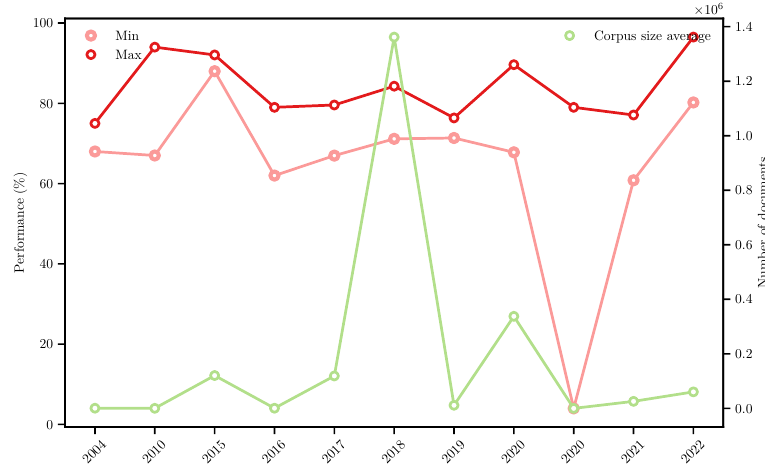
Figure 5. Historical performance of judicial decision prediction.